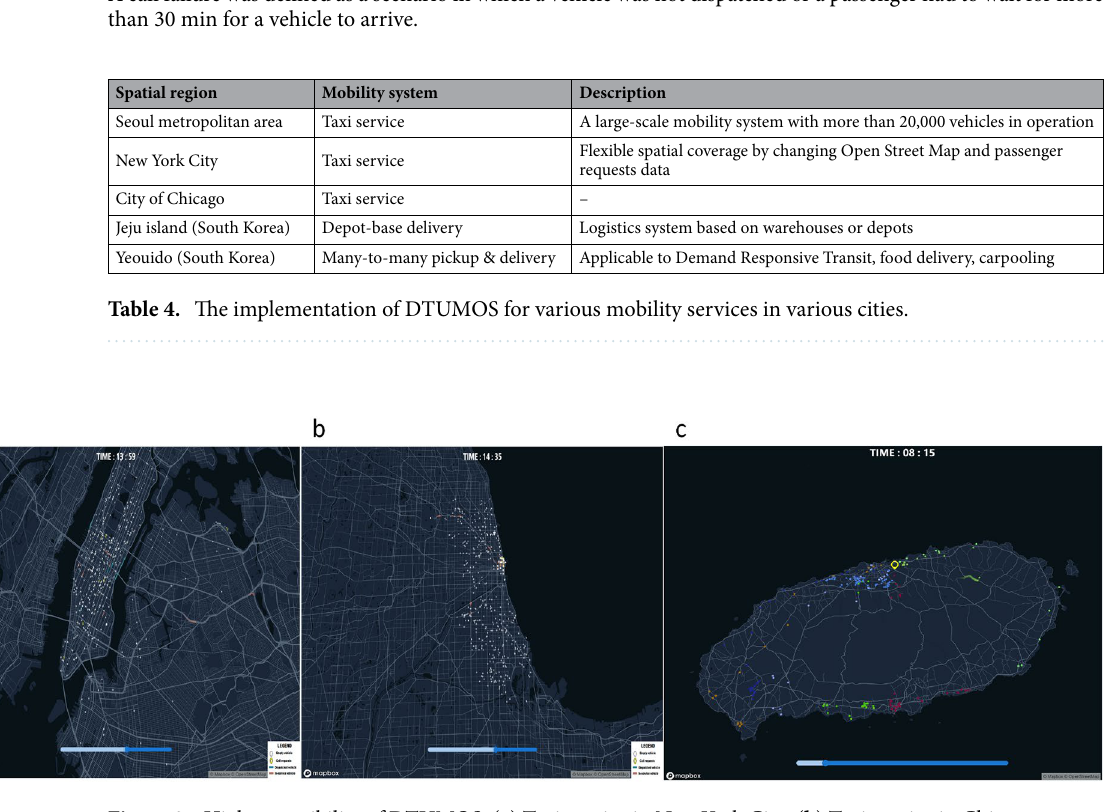
Figure 3. High extensibility of DTUMOS: ( a ) Taxi service in New York City; ( b ) Taxi service in Chicago; ( c ) Logistics Delivery Service in Jeju island in South Korea. The map is created using Mapbox GL JS v.2.12.0 (https:// www. mapbox. com/).